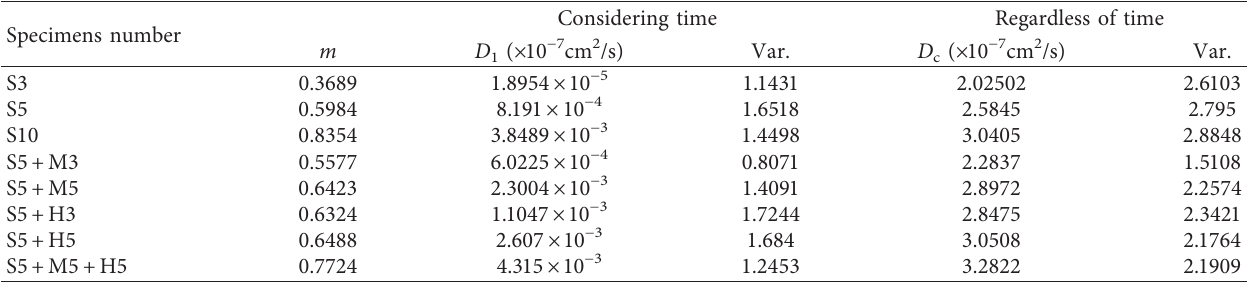
with or without consideration of time in 4